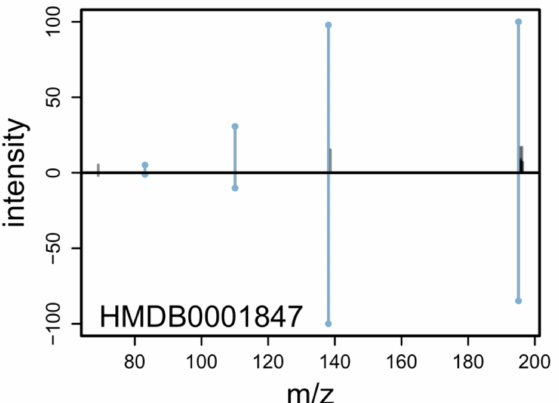
Figure 3. Mirror plot created with plotSpectraMirror for visual inspection of MS 2 annotation results. The upper panel shows an experimental MS 2 spectrum and the lower a reference spectrum for Caffeine from HMDB. Matching peaks are highlighted in